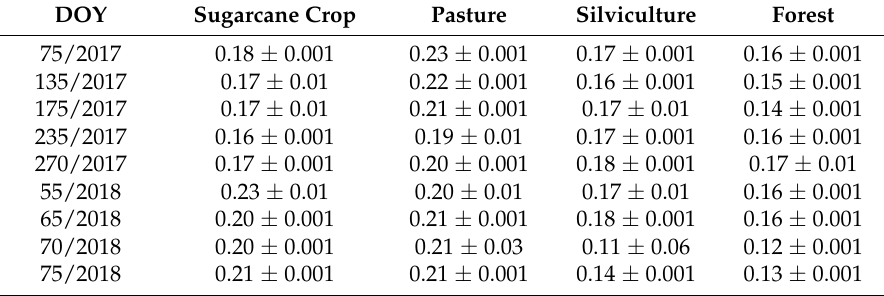
Table 1. Mean values and standard deviations at a daily scale of surface albedo between 2017 and 2018 by land use and day of year (DOY). DOY Sugarcane Crop